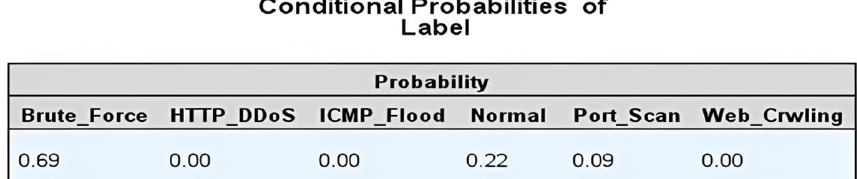
Fig. 4 Conditional probabilities of level target